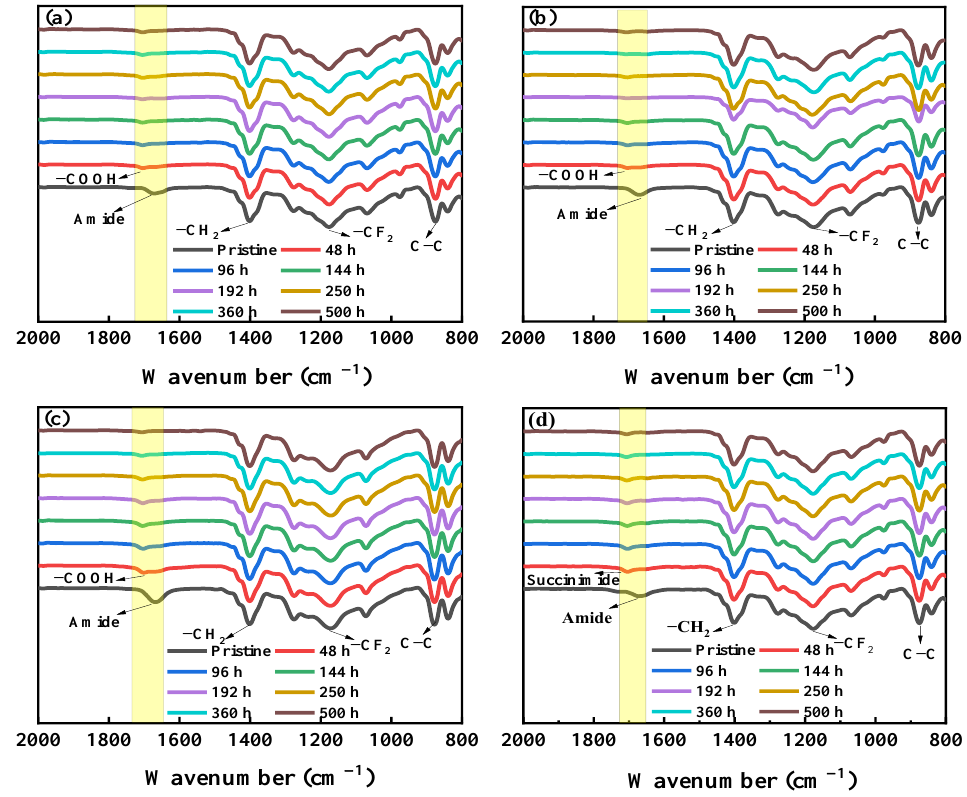
Figure 2. FTIR spectra of the pristine and NaOCl-exposed membranes. ( a ) A membrane, NaOCl pH = 10; ( b ) B membrane, NaOCl pH = 10; ( c ) C membrane, NaOCl pH = 10; and ( d ) A membrane, NaOCl pH = 8.